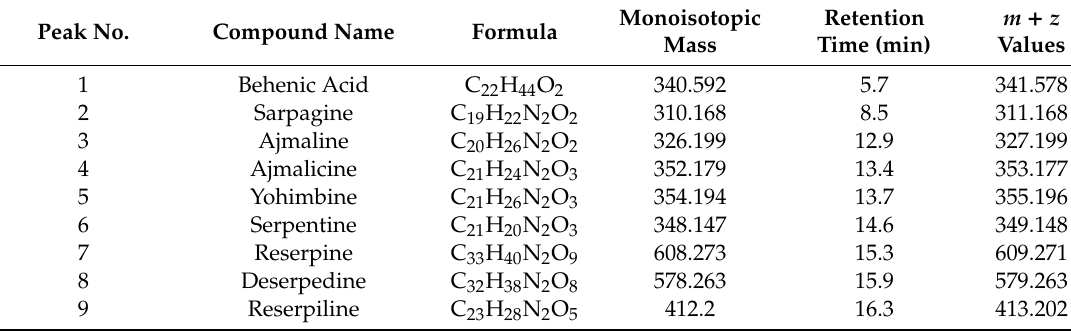
Table 1. List of identified compounds in electron spray ionization (ESI) positive mode of ionization from R. serepentina hydroalcoholic extract by UHPLC-QTOF analysis. Peak